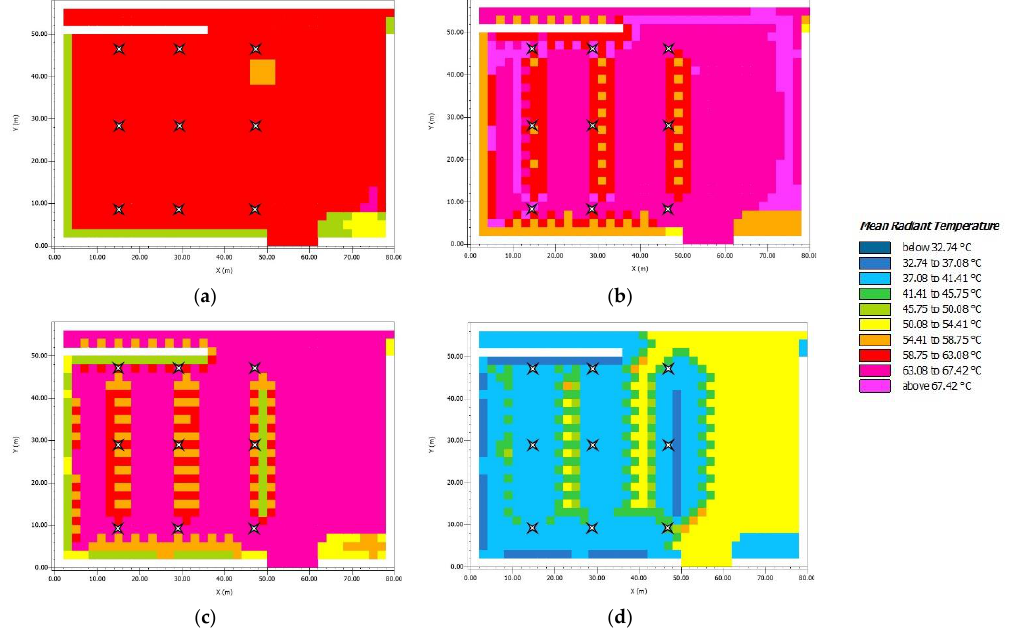
Figure 9. MRT at 12.00 a.m. in July. ( a ) AS; ( b ) LC+G1; ( c ) LC+G2; ( d ) LC+G3. Figure 9. MRT at 12:00 a.m. in July. ( a ) AS; ( b ) LC+G1; ( c ) LC+G2; ( d )